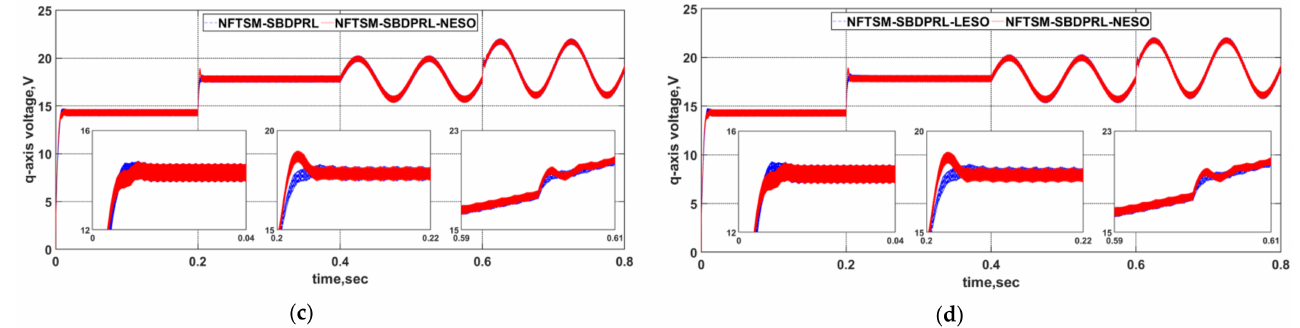
Figure 3. Control signals ( q -axis voltage) of the PMSM under the five control methods for comparison: ( a ) NTSM-FPRL and NFTSM-SBDPRL-NESO, ( b ) NFTSM-DPRL and NFTSM- SBDPRL-NESO, ( c ) NFTSM-SBDPRL and NFTSM-SBDPRL-NESO, ( d ) NFTSM-SBDPRL-LESO and NFTSM-SBDPRL-NESO.